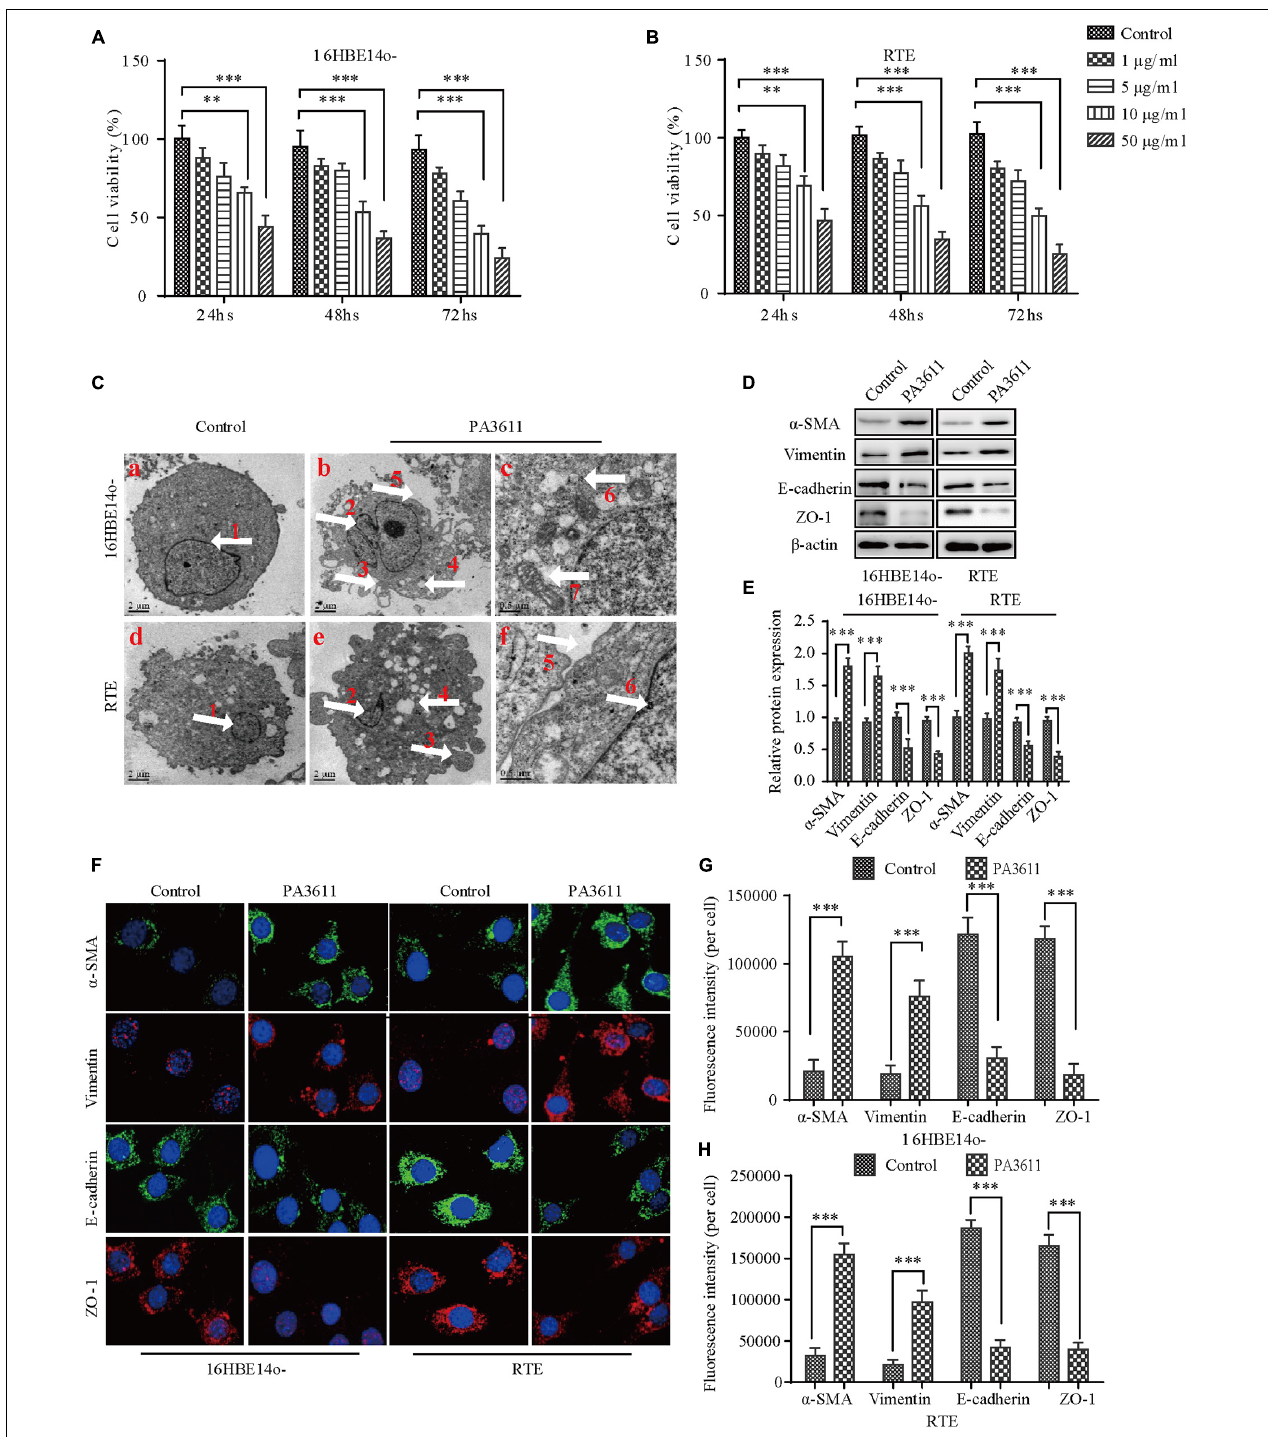
FIGURE 1 | Effects of PA3611 on the proliferation and epithelial-mesenchymal transition (EMT) of bronchial epithelial cells. 16HBE14o- and RTE cells were treated with different amounts of PA3611 (1, 5, 10, and 50 µ g) for 24, 48, or 72 h. A CCK-8 assay was performed to estimate cell proliferation (A,B) . Transmission electron microscopy was used to observe the ultrastructure of the above cells treated with PA3611 (10 µ g/mL) for 48 h (C) . EMT-related protein ( α -SMA, vimentin, E -cadherin and ZO-1) levels in 16HBE14o- and RTE cells at 48 h were assessed by Western blot analysis (D–F) . Fluorescence intensities of EMT-related proteins ( α -SMA, vimentin, E -cadherin and ZO-1) were assessed by immunofluorescence staining in 16HBE14o- and RTE cells at 48 h (F–H) , and photographs were obtained with a confocal laser microscope (100 × objective lens). All the presented graphs are representative of the results of three independent experiments. The data are presented as the mean ± SD. ∗ P < 0.05, ∗∗ P < 0.01, ∗∗∗ P < 0.001, vs. the control group. White arrow (cid:172) and (cid:173) nucleus; (cid:174) cells crest; (cid:175) cells vacuolation; (cid:176) intercellular gaps; (cid:177) intracellular glycogen; (cid:178) mitochondria.